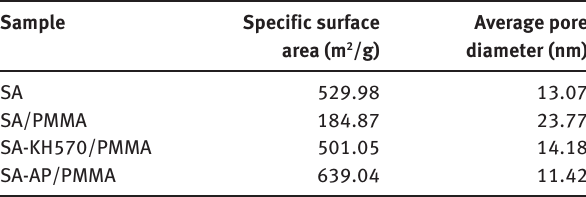
Table 1: Specific surface area and average pore diameter data of silica aerogel (SA) and composites.